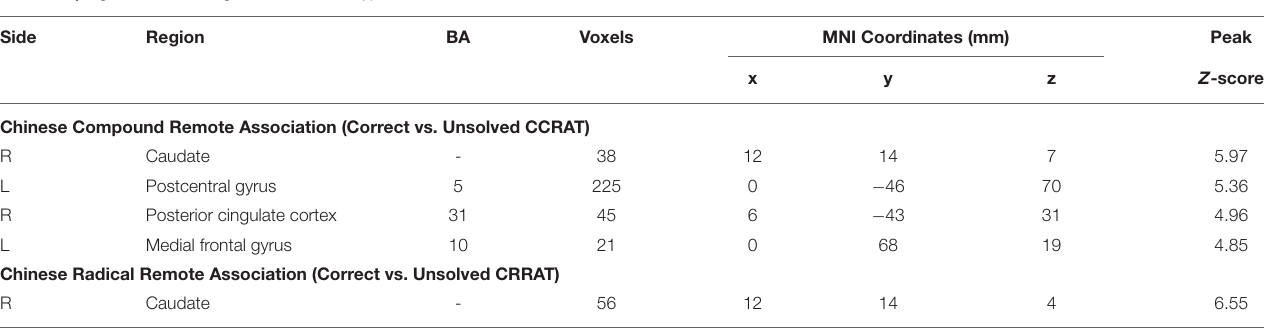
TABLE 2 | Significant brain regions for different types of remote associations.